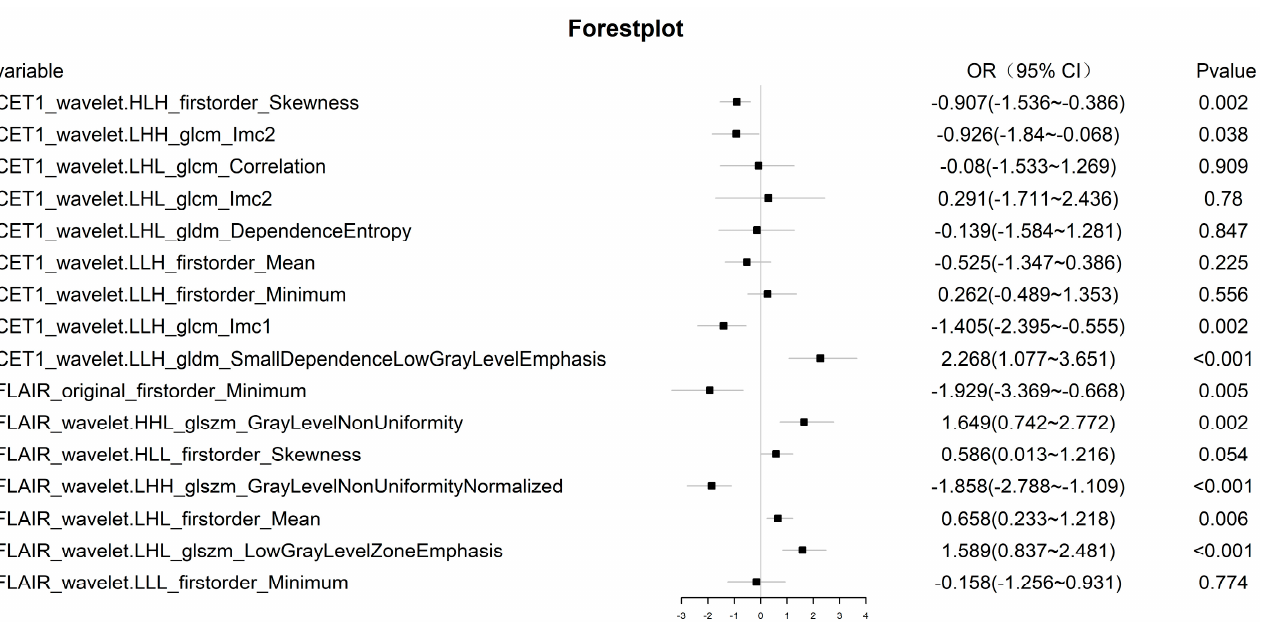
Figure 5. ROC curves of the SMOTE training cohort, un-SMOTE cohort, test cohort and independent TCGA/TCIA cohort.